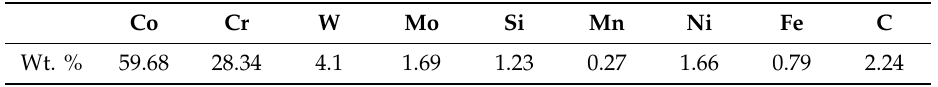
Table 1. Chemical composition values determined by energy dispersive X-ray spectroscopy (EDX) measurement and verified as identical to nominal composition (mass